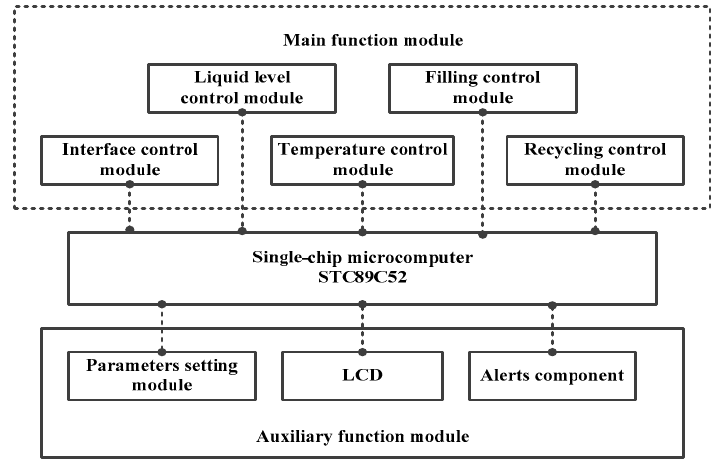
Figure 10. Block diagram of the control device and its functions.